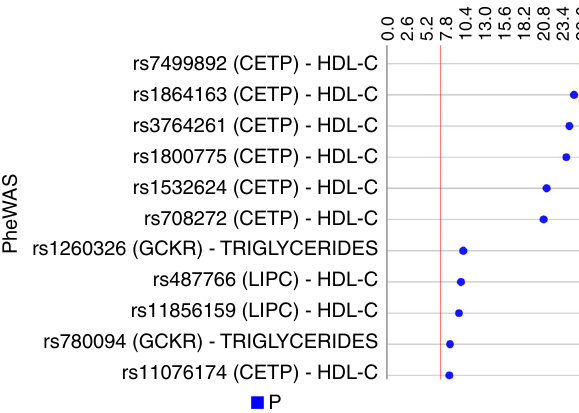
Fig. 5 The top PheWS results. PheWAS using linear or logistic regression (depending on whether the outcome was binary or continuous) in PLATO. phenotype association on the left and the track to the right displays the – log10 of the uncorrected p value. The red line denotes the Bonferroni threshold for corrected signi fi cance (uncorrected LRT p : 9.30 × 10 − 8 ; α